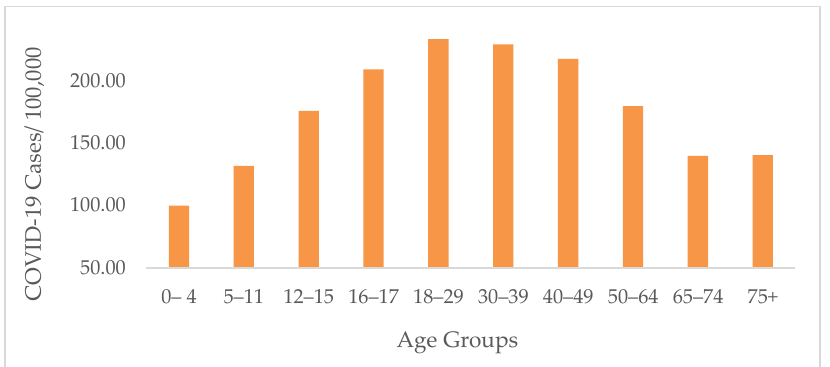
Table 2. Rates of COVID-19 cases and deaths by age group in the selected states from January 2020 through February 2022.